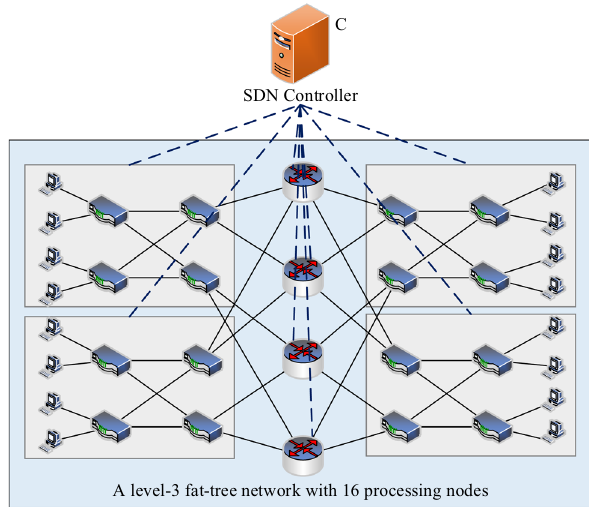
Fig. 9. Among them, different nodes have different buffer